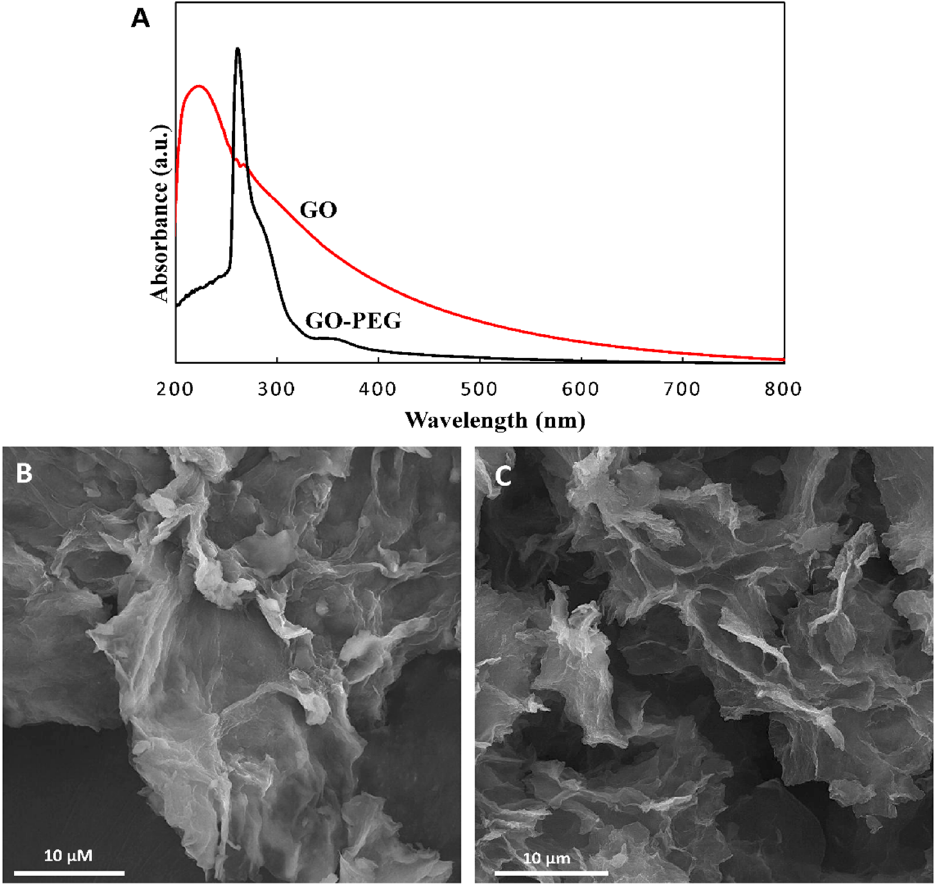
Figure 2. ( A ) UV–Vis spectra of GO and GO-PEG; ( B ) The FE-SEM images of GO and ( C ) The FE-SEM images of GO-PEG.